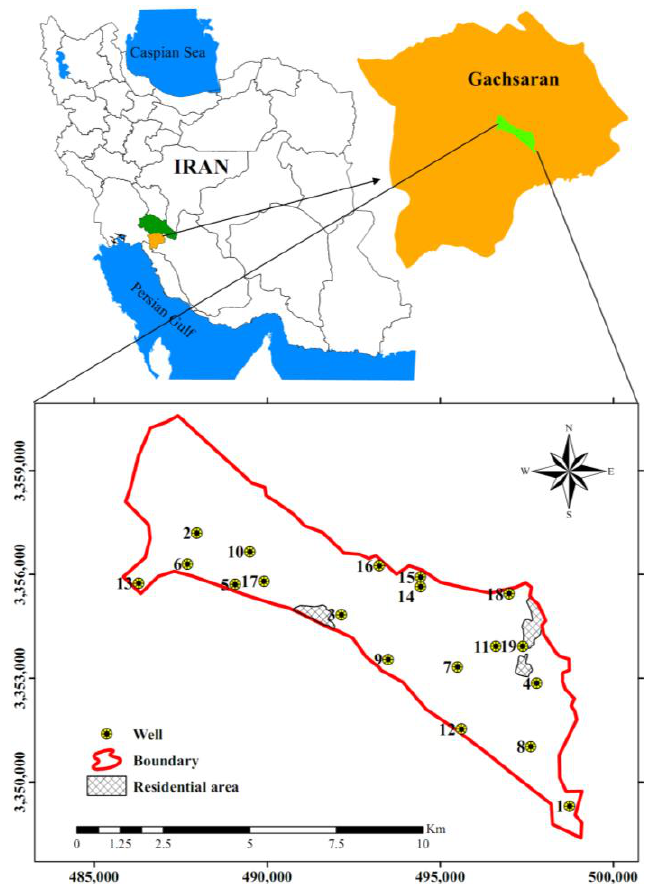
Figure 1. The Imam Zadeh Jafar Aquifer located in Gachsaran City, southwest Iran.